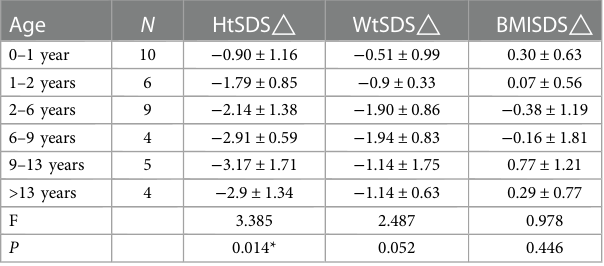
TABLE 2 Growth of 45,X/46,XY mosaicism in different age